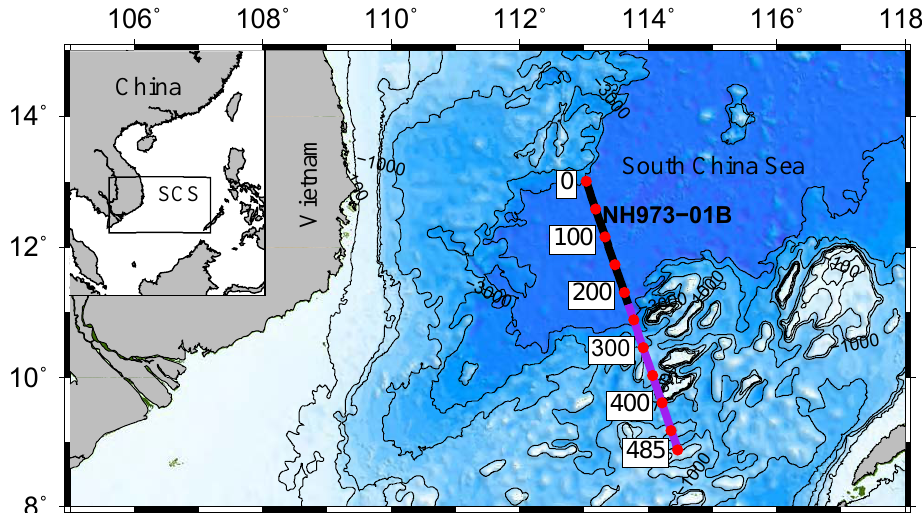
Fig. 1. Bathymetry of the southern South China Sea. The seismic line NH973–01B, labelled with distances (in units ofkm) from the starting point, is divided into two subsections. There is a time gap of 5h at the line